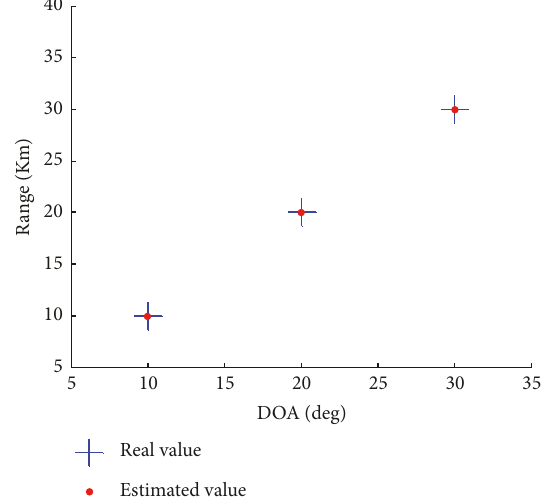
Figure 3: The estimated results of the angle and range.